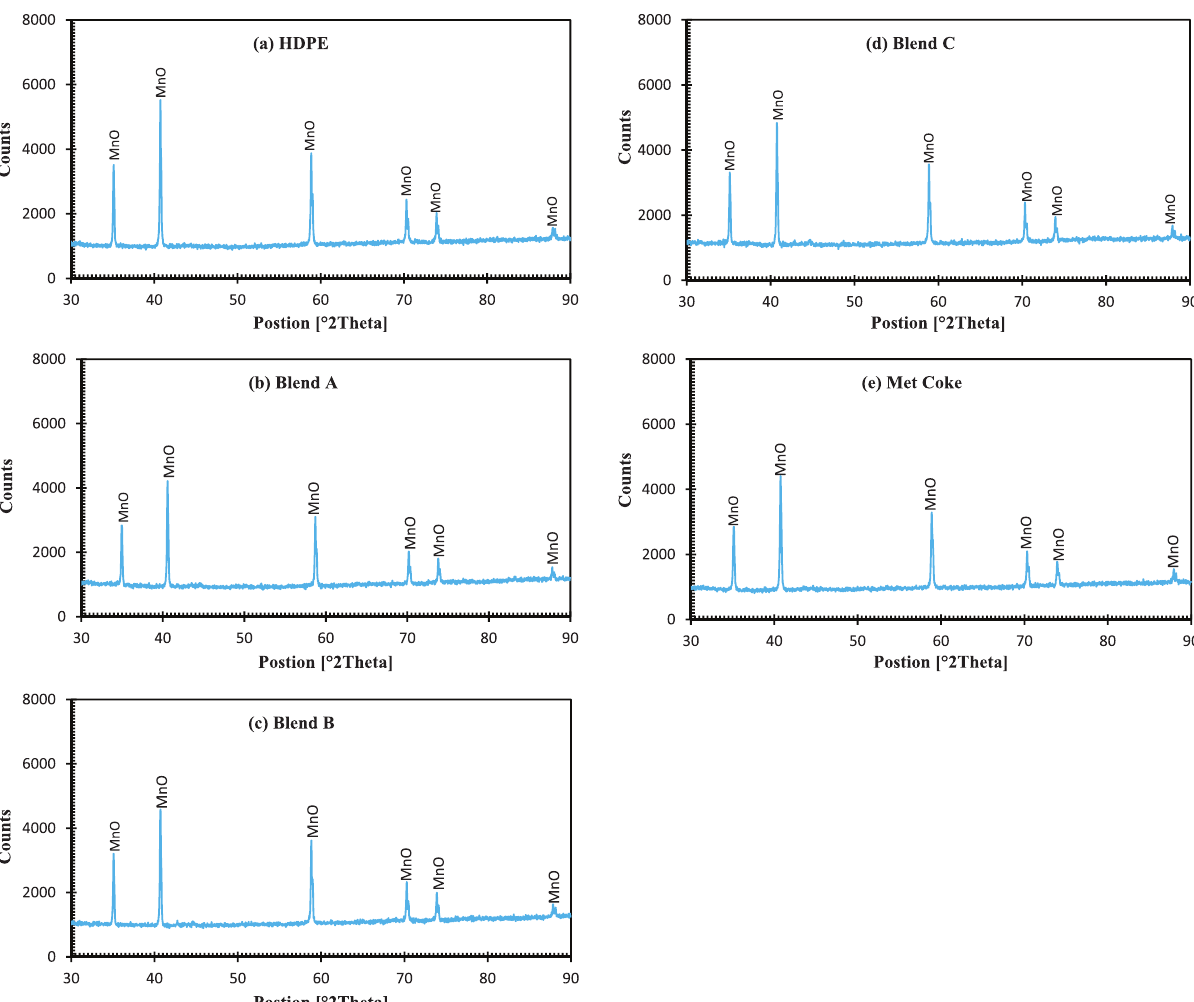
Fig. 6: XRD patterns obtained after pre-reduction of Mn 3 O 4 at 1150 °C by each reductant.